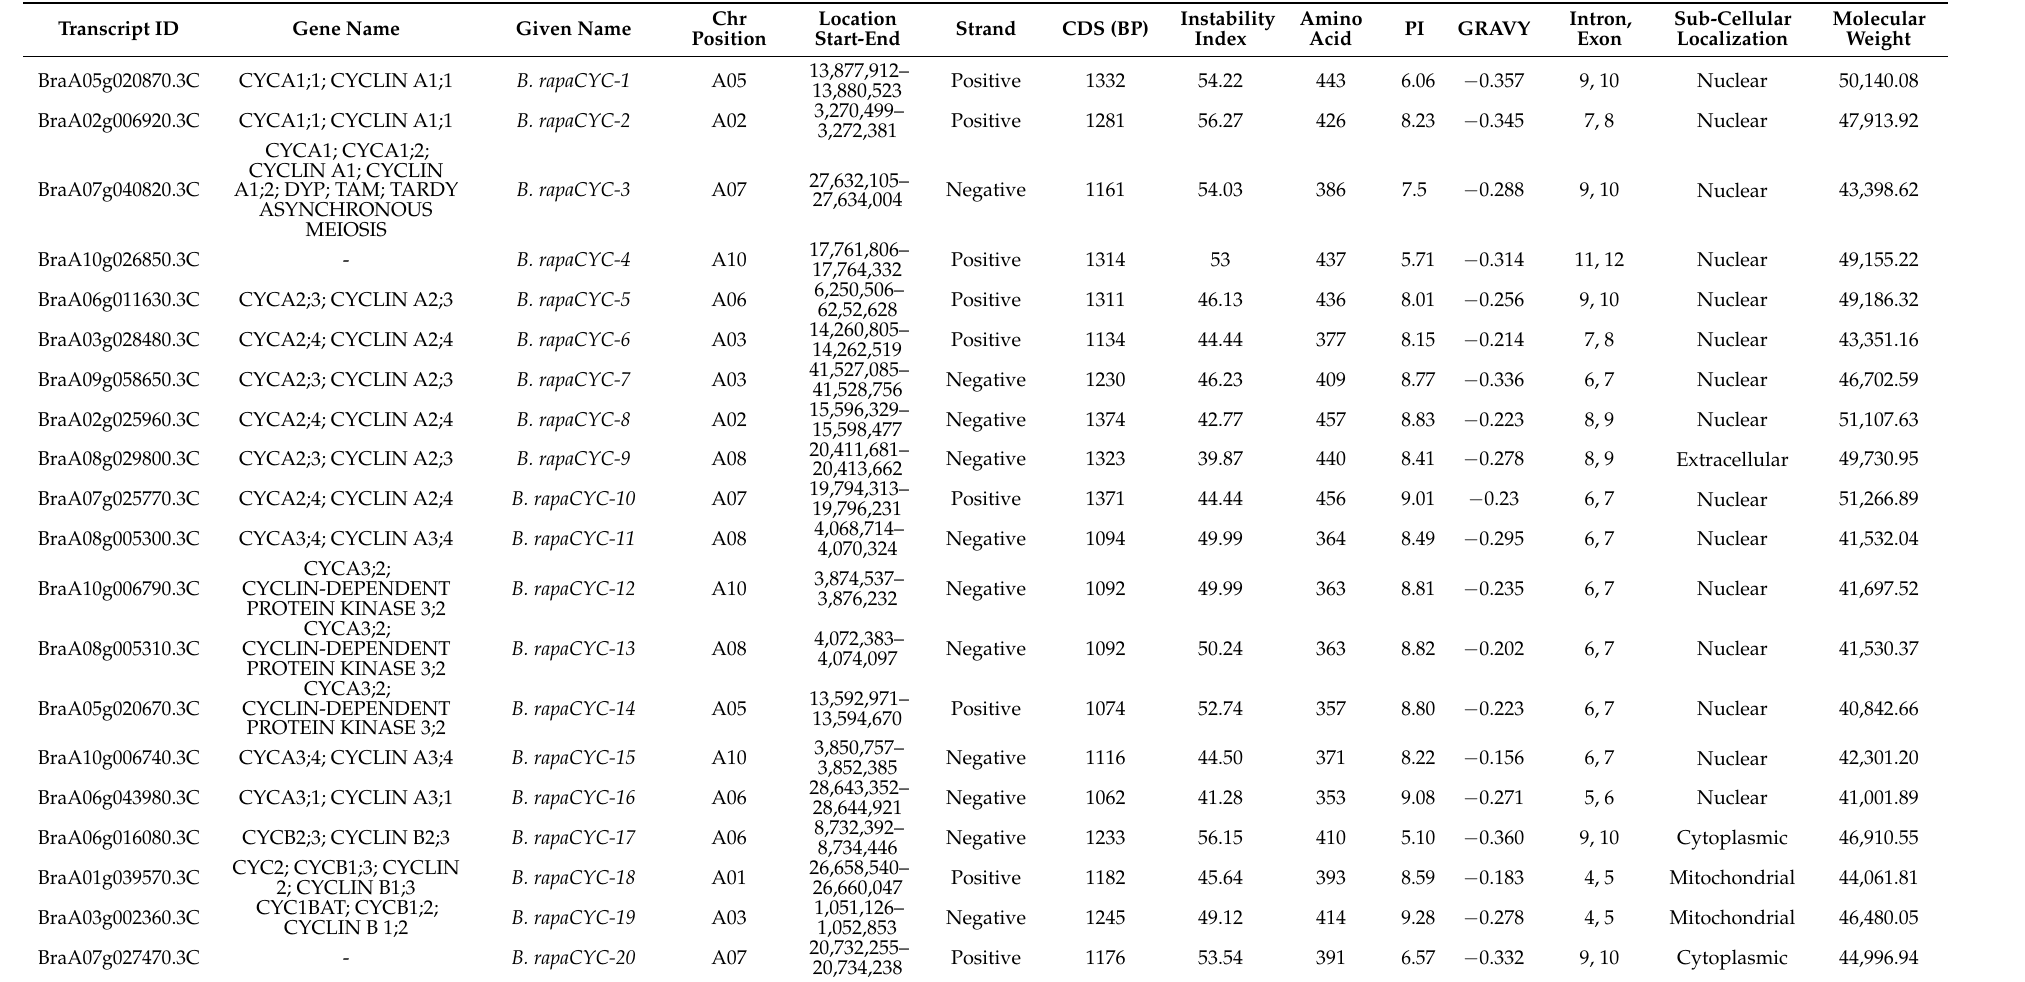
Table 1. List of the cyclin genes identified in Brassica rapa . Predicted genes and related